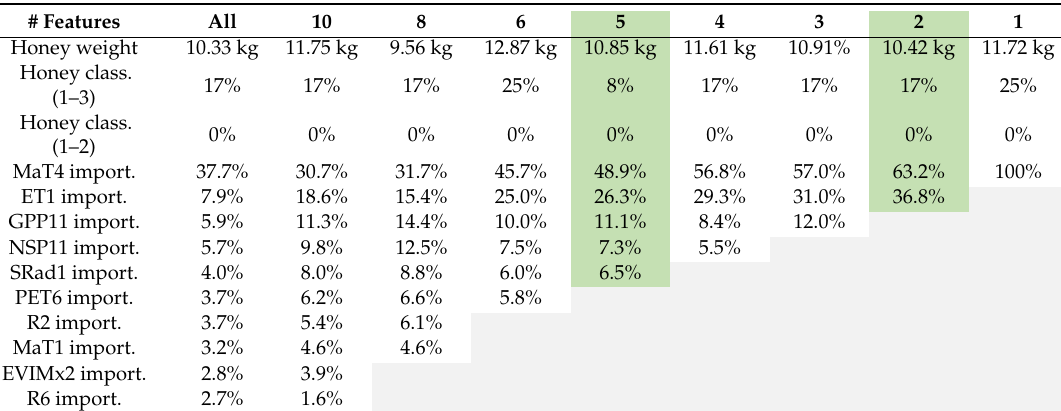
Table 6. Gradient Boosted Regression errors and feature importance (import.) for di ff ering number of input